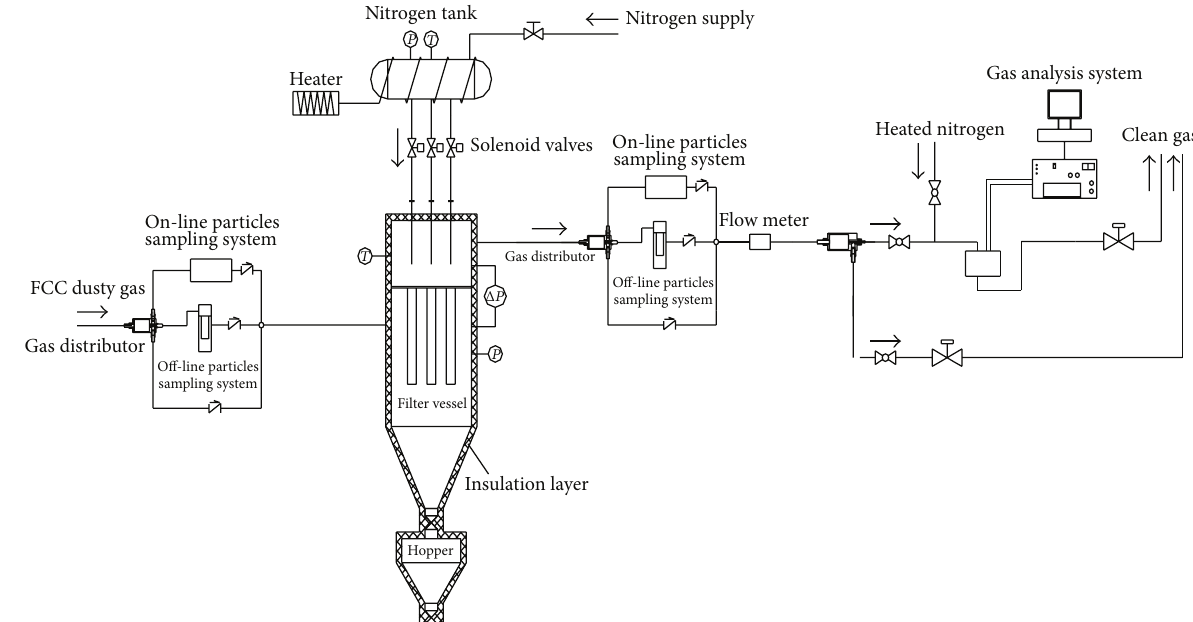
Figure 2: Schematic diagram of the hot gas filtration